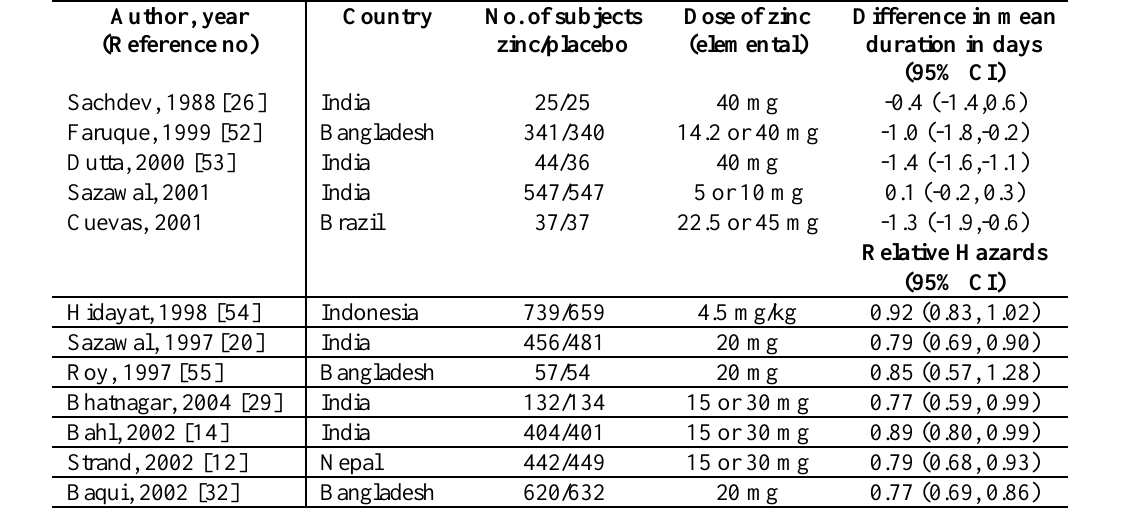
Table II : Studies evaluating therapeutic effects of zinc supplementation in the treatment of acute diarrhea